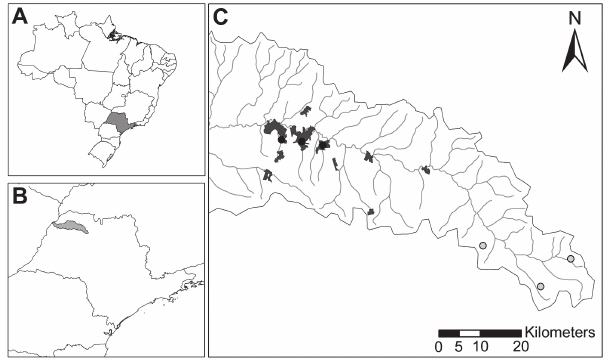
Fig. 1. Map of the study area, showing: the state of São Paulo (A); and the rio São José dos Dourados basin (B), where the forested streams (black circles), which were located in the largest forest fragments of the river basin (grey areas), and the deforested streams (grey circles) were located